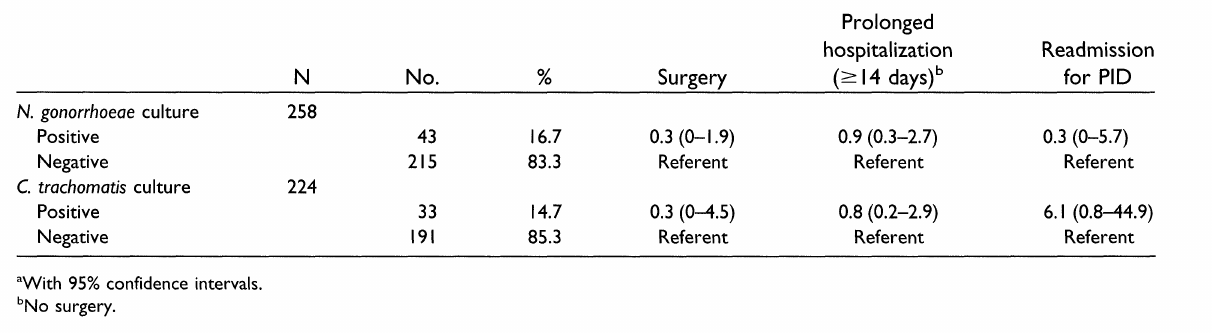
aWith 95% confidence intervals. bNo surgery. TABLE 4. Adjusted odds ratios for complicated clinical course among HIV-negative women with clinically diagnosed pelvic inflammatory disease Potential predictor Surgery